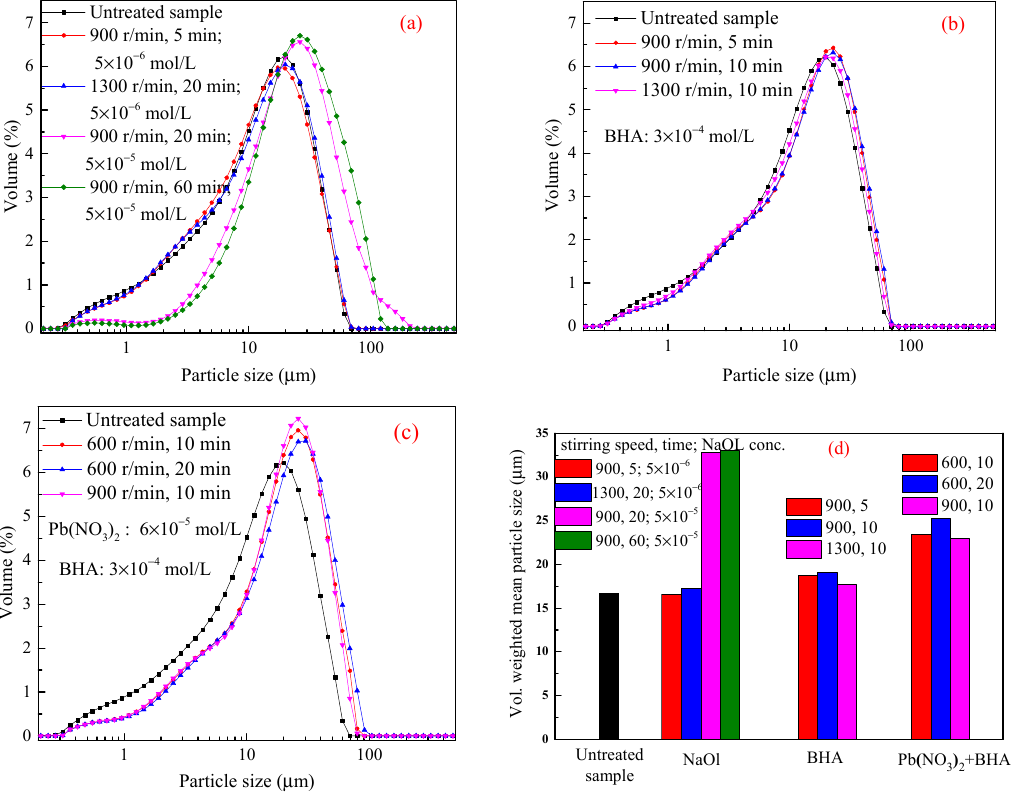
Figure 8. The particle size analysis results of − 23 μ m cassiterite in the presence of NaOL ( a ), BHA ( b ), and Pb 2+ + BHA ( c ) under different stirring conditions, ( d ): vol. weighted mean particle size (pH = 8.5–9).